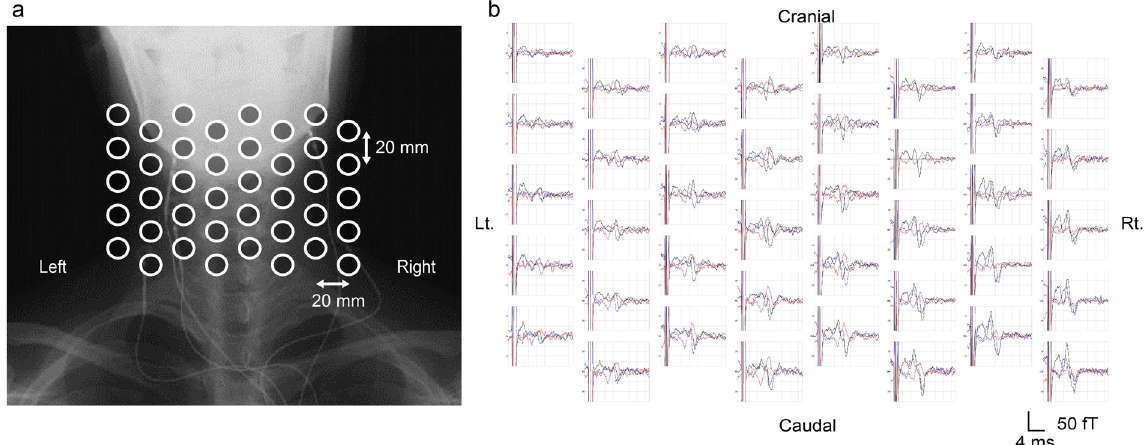
Figure 5. Spinal cord evoked magnetic fields (SCEFs) in response to stimulation of the median nerve at the elbow. ( a ) Positions of the sensors. ( b ) SCEFs illustrated in a manner similar to Fig. 1. SCEFs were mainly recorded from the right side of the spinal